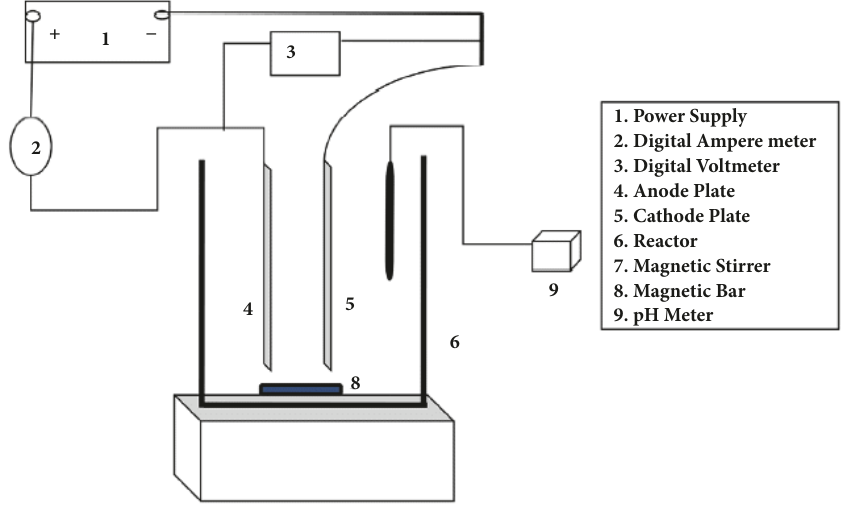
Figure 1: Electrocoagulation